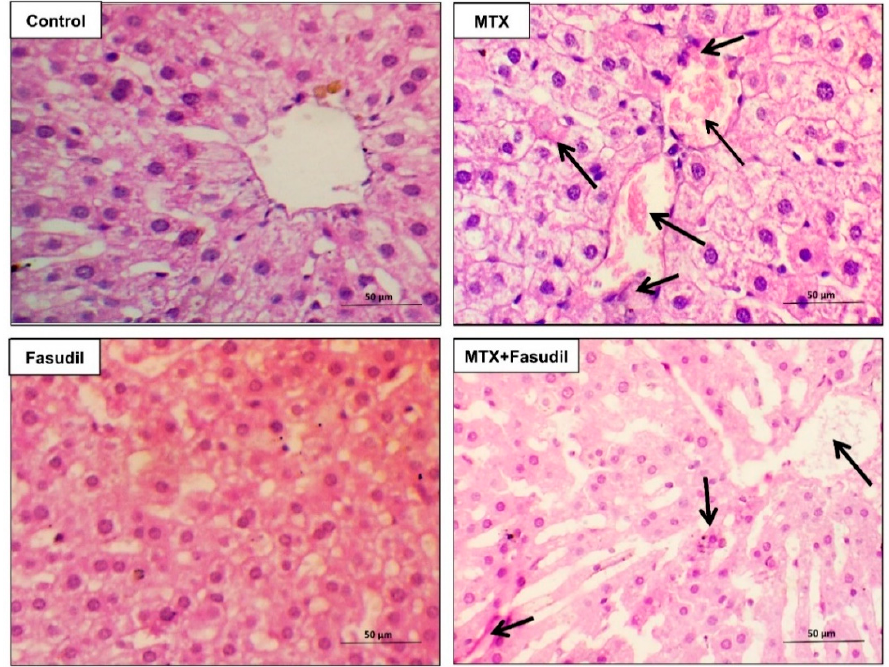
Figure 3. Fasudil ameliorated MTX-induced hepatic histopathological aberrations. Routine staining (hematoxylin and eosin (H&E) stain, ×400) was conducted to examine control, MTX, fasudil, and MTX + fasudil groups. Arrows mark hepatic changes, including hepatocyte degeneration and congestion with inflammatory cell infiltration. Scale bar = 50 μ m.